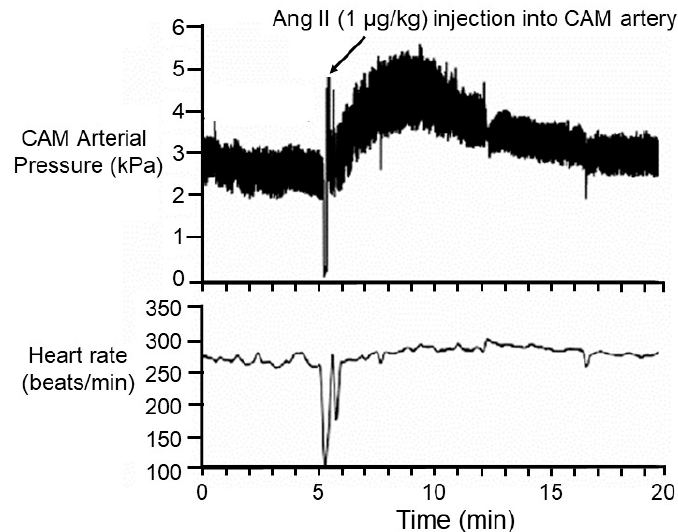
Figure 3. Arterial blood pressure traces and calculated heart rate in a Day 21 chicken embryo before and after injection of the hypertensive agent, angiotensin II. Blood pressure was measured in a chronically indwelling cannula that had been implanted in a CAM artery by keyhole surgery through a small hole in the eggshell. CAM arterial blood pressure, assumed to be a proxy for systemic embryonic pressure, increased dramatically within less than a minute after injection, and stayed elevated for at least 15 min. Heart rate was largely unchanged. These data indicate that receptors for ang II are present at hatching, typically occurring on Day 21 post-fertilization. Modified from [83].